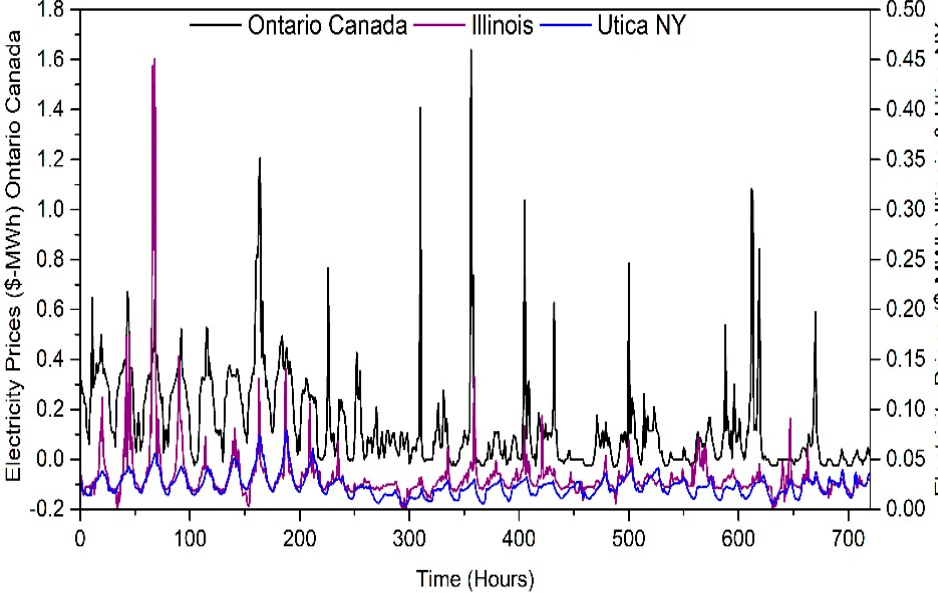
Figure 3. Hourly energy